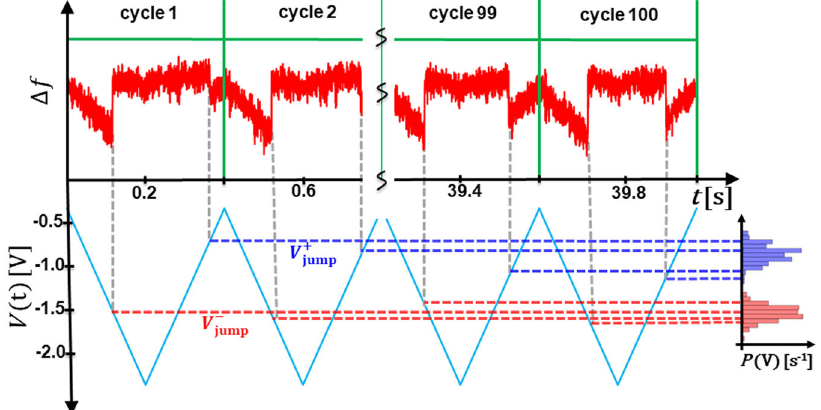
Fig. 3 FC-KPFS protocol. Time variations of the frequency shift Δ f due to the bias voltage ramps shown below. Solid green vertical lines separate complete cycles, while dashed blue and red lines indicate voltages V þ jump and V (cid:1) jump at which frequency shift jumps happen. Acquired values of the V þ jump and V (cid:1) jump voltages form, correspondingly, recharging (blue) and discharging (red) distributions shown on the right.